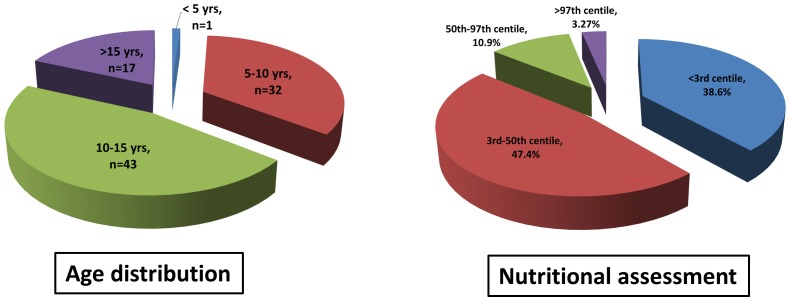
Age distribution and nutritional assessment in children with ARF.